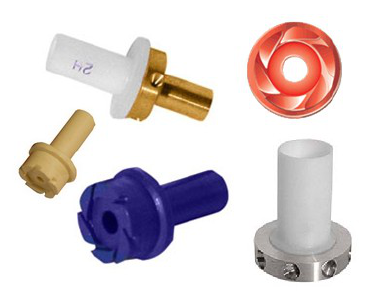
Figure 2. Different vortex generators